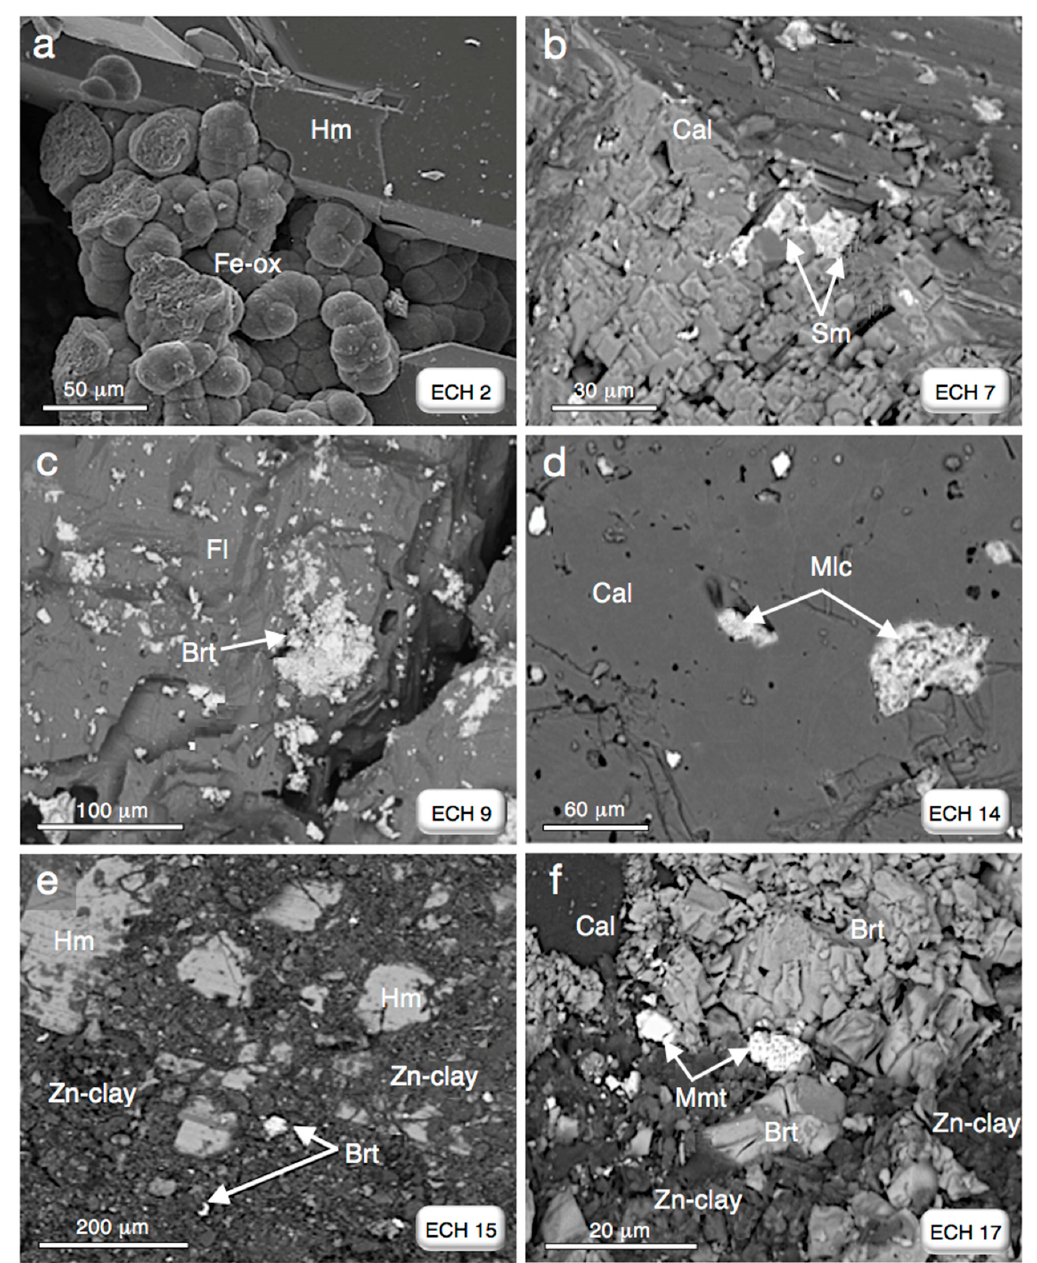
Figure 7. SEM-BSE micrographs of selected samples from the Bou Caïd orefield. ( a ) Large hemimorphite crystals with globular Fe-oxy-hydroxides aggregates; ( b ) calcite with smithsonite fillings; ( c ) fluorite with disseminated barite; ( d ) malachite in vugs of calcite; ( e ) hemimorphite with Zn-clays layers; ( f ) rare occurrence of mimetite, together with Zn-clays, calcite and barite. Brt: barite; Cal: calcite; Cer: cerussite; Fe-ox, mixed Fe-oxy-hydroxides; Fl: fluorite; Hm: hemimorphite; Mlc: malachite; Mmt: mimetite; Sm: smithsonite.